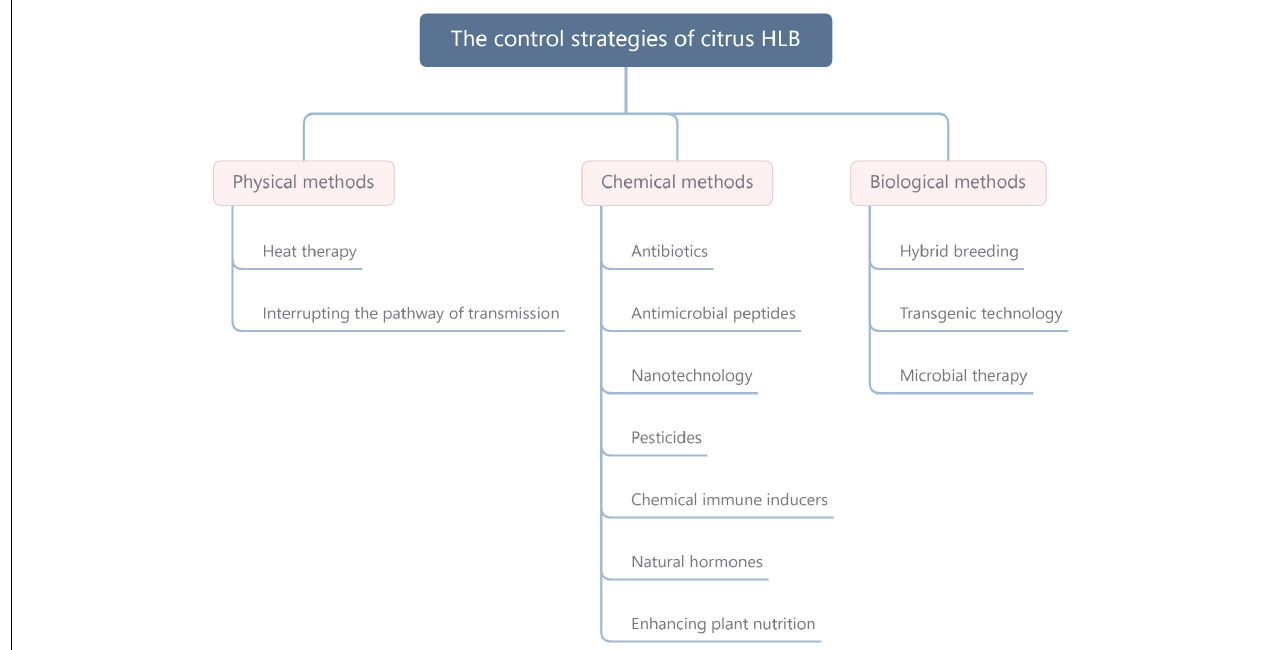
FIGURE 1 | The control strategies of citrus HLB mainly include physical methods, chemical methods, and biological methods. HLB,